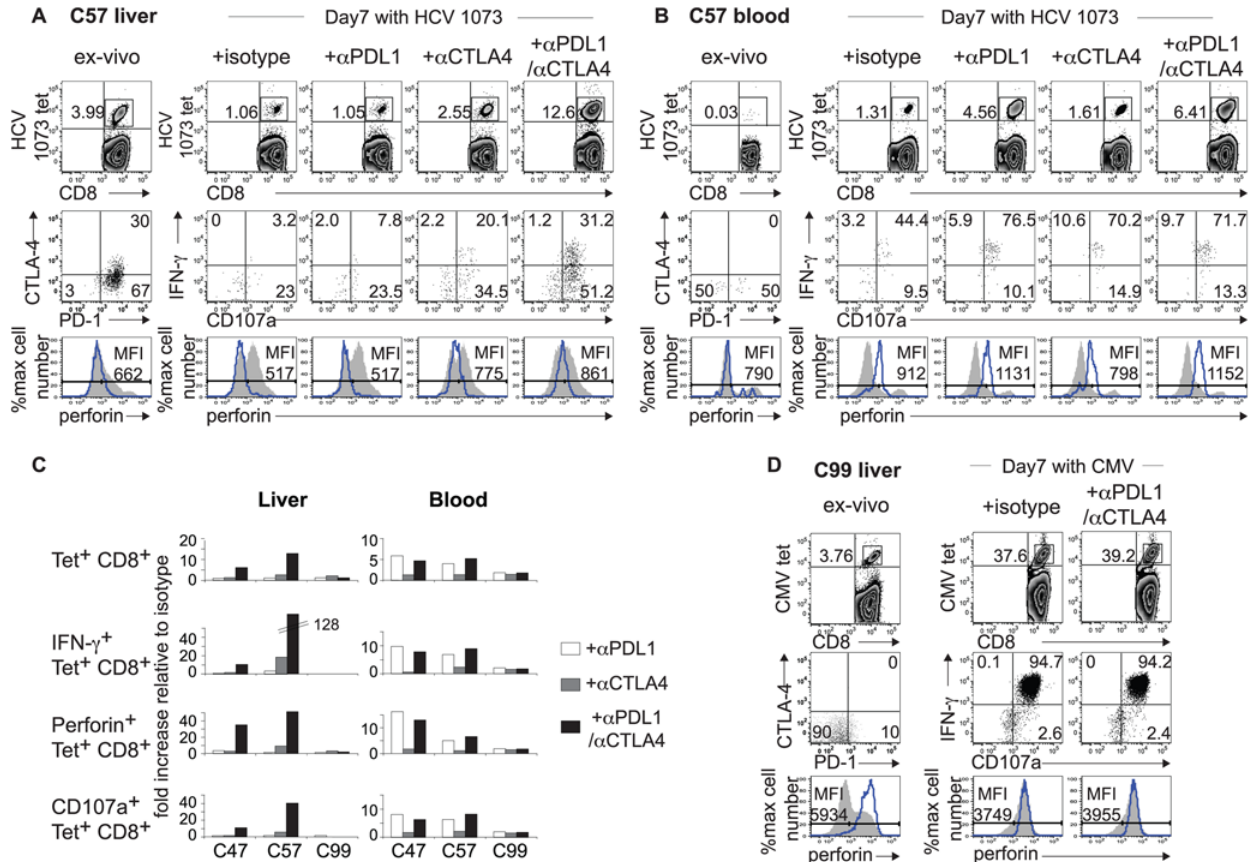
Figure 4. Effect of PD-1/CTLA-4 blockade on intrahepatic and peripheral HCV-specific tetramer + CD8 T cell function. Flow cytometry plots showing HCV 1073-specific CD8 T cell phenotype directly ex vivo and antigen-specific functions following 7 days of antigenic stimulation in the presence of isotype or blocking antibodies, using liver-derived (A) and blood-derived (B) lymphocytes from chronic patient C57. (Top panels): frequency of HCV 1073-specific CD8 T cells determined by cognate HLA-A2 tetramer staining. (Middle panels) far left: PD-1 and CTLA-4 expression ex vivo in gated tetramer + CD8 T cells (dot plots). Remaining right panels: HCV-specific IFN- c production and CD107a mobilization in gated tetramer + CD8 T cells on day 7. (Bottom panels): Perforin expression in tetramer + (blue line) and total CD8 T cells (gray shaded) on day 7. (C) Fold increase in the expansion and effector functions of liver-derived (left) and blood-derived (right) HCV-specific CD8 T cells by a PD-L1 alone (white bar), a CTLA-4 alone (gray bar) and combined a PD-L1/ a CTLA-4 blockade (black bar) relative to the isotype control for 3 chronic patients. The frequencies of functional tetramer + CD8 T cells in each culture were calculated by multiplying %tetramer + CD8 T cells with %IFN- c + /tetramer + CD8 T cells, %perforin + /tetramer + CD8 T cells or %CD107a + /tetramer + CD8 T cells. (D) Flow cytometry plots showing CMV-specific CD8 T cells directly ex vivo and their antigen-specific functions following 7 days in vitro cultures from chronic patient C99.